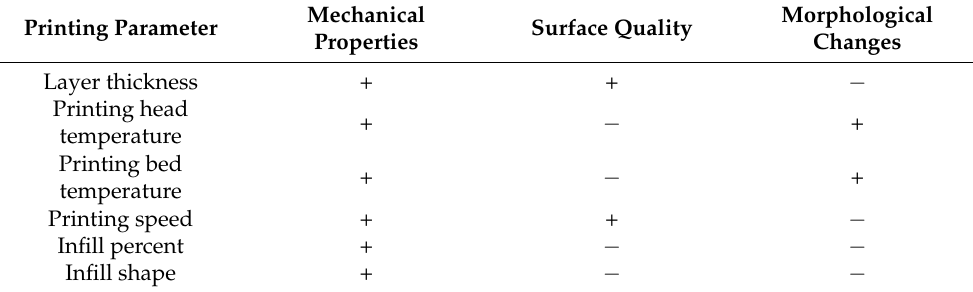
Table 2. Influence of main printing parameters on part properties.